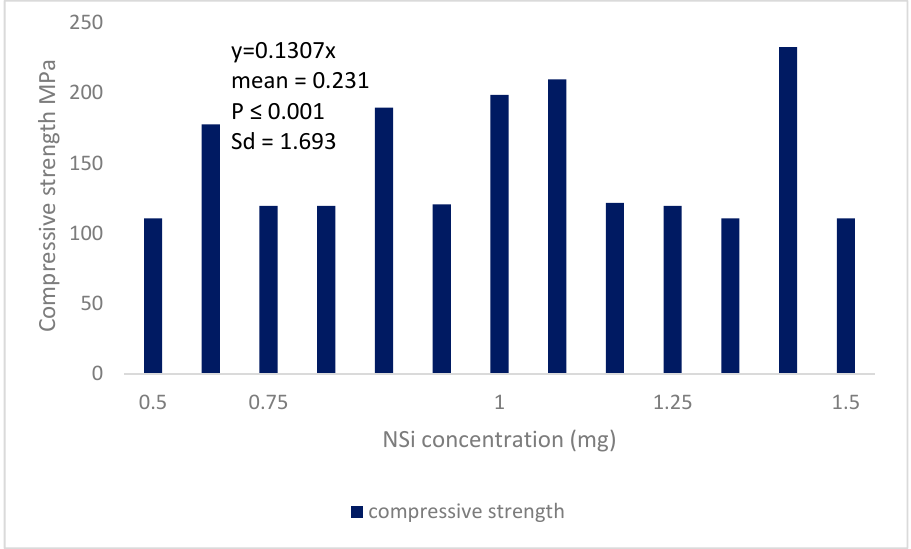
Gels 2022 , 8 , x FOR PEER REVIEW